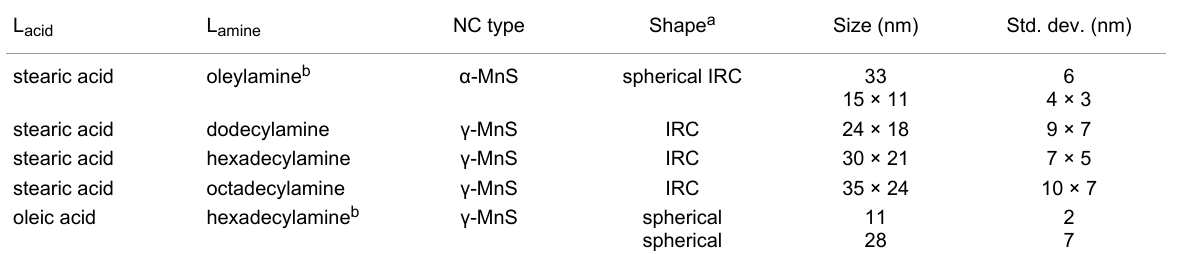
Table 3: Properties of NCs synthesized by the thermal decomposition of Mn 2 (CO) 10 with S/Mn = 2 and using both amine and carboxylic acid as a free surfactant (L amine /Mn = 4:1, L acid /Mn = 2:1).